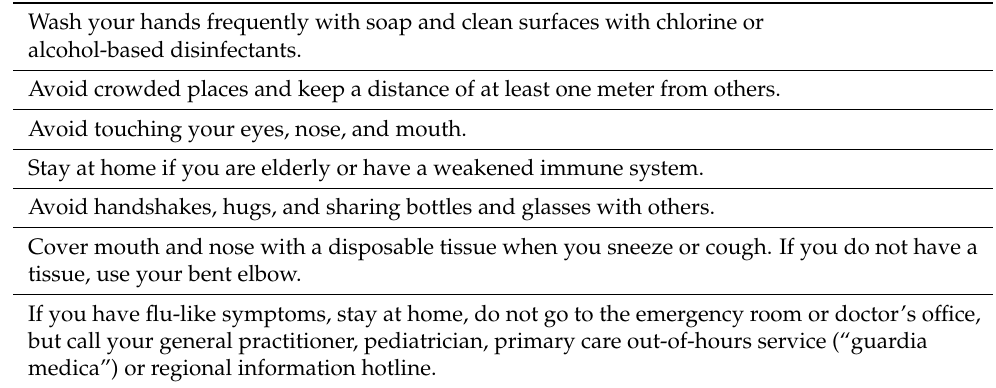
Table 3. Recommendations of the Italian Ministry of Health to contain the spread of coronavirus.